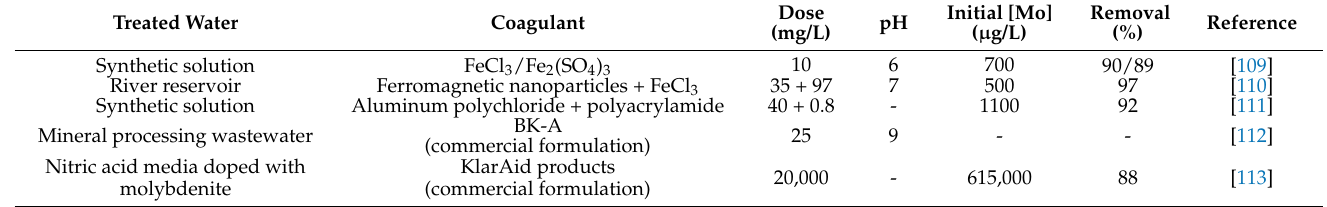
Table 9. Compilation of the main coagulants tested for molybdenum removal from aqueous solutions. Treated Water Coagulant